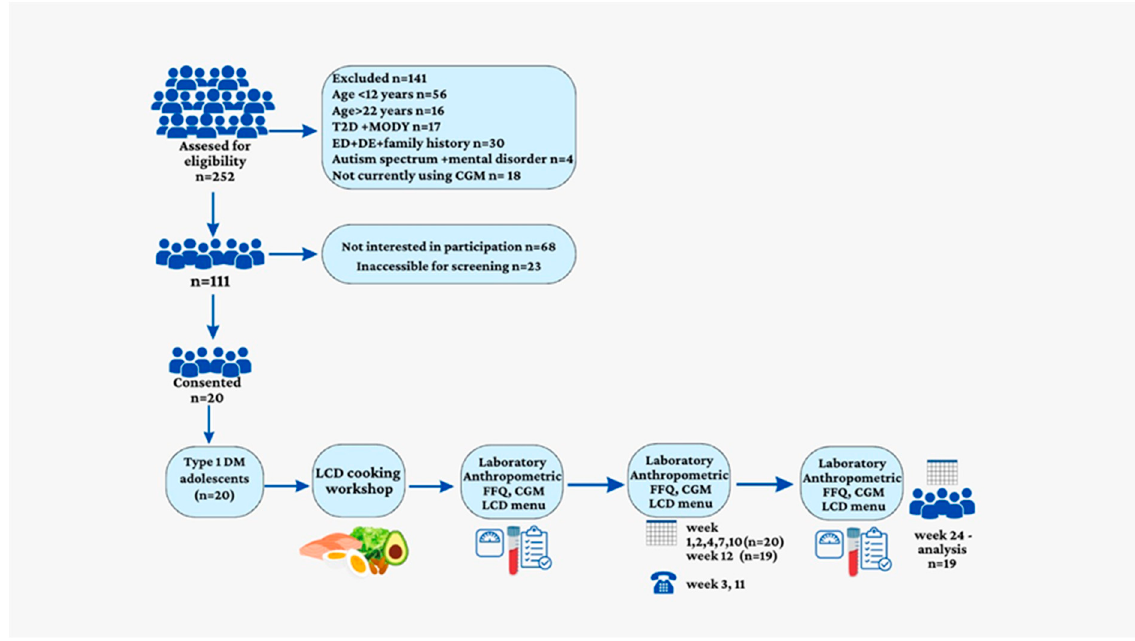
Figure 1. Flow chart of the study enrolment and regime .